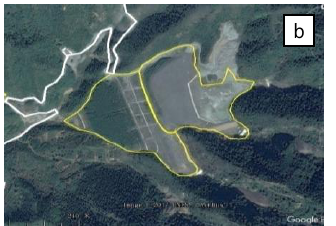
Fig. 5 Temperature distribution of tailings pond. a) Temperature image of tailings pond; b) GeoEye iamge of tailings ponds.